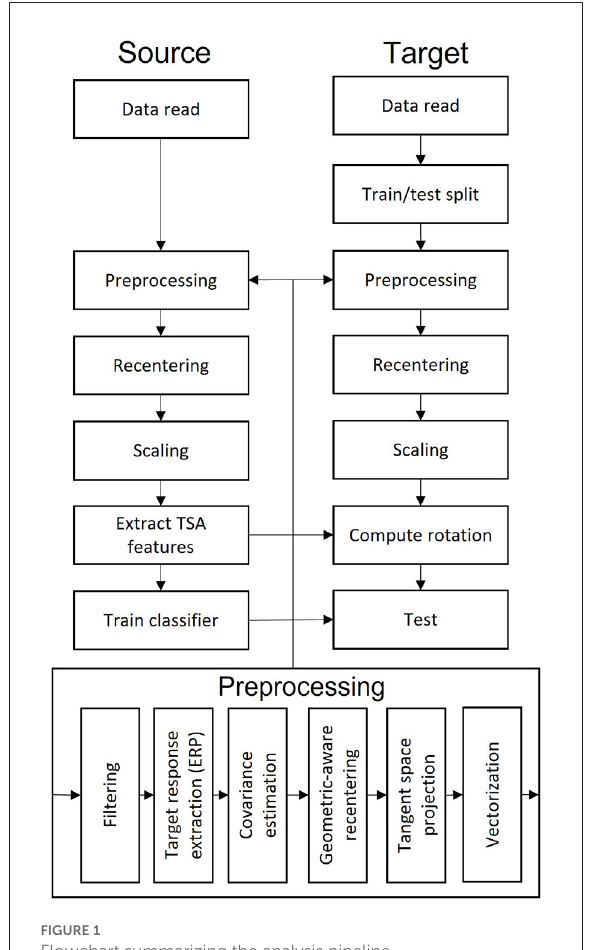
FIGURE1 Flowchart summarizing the analysis pipeline.